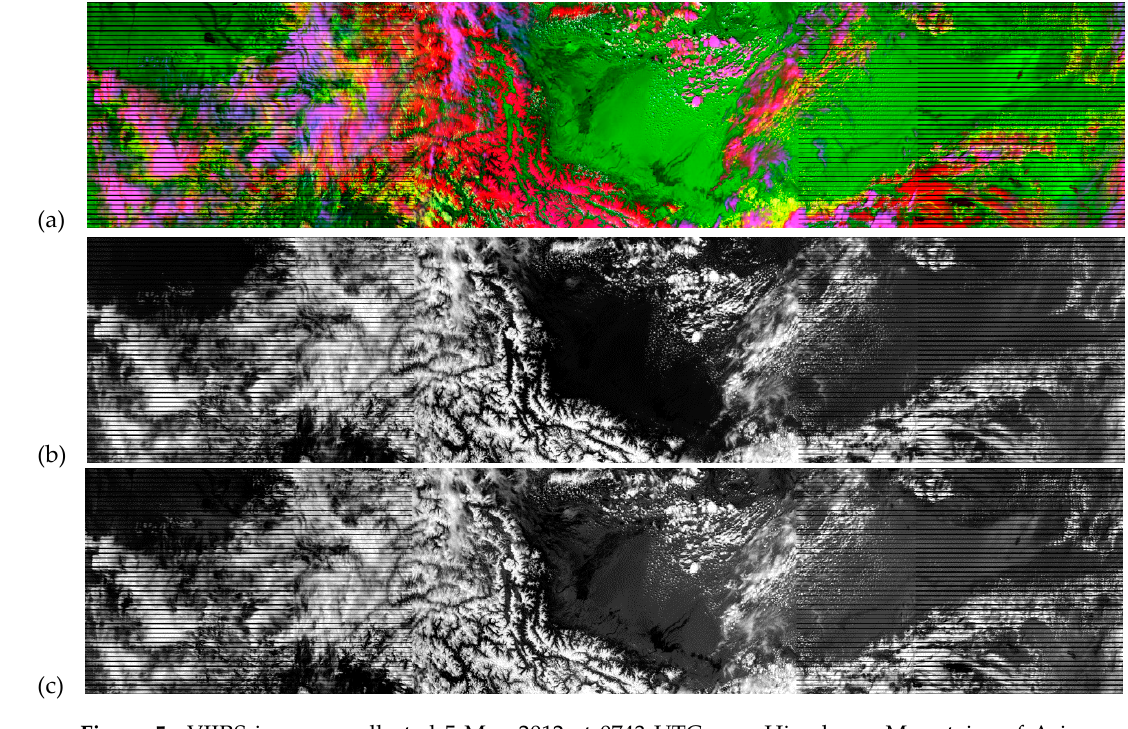
Figure 5. VIIRS imagery collected 5 May 2012 at 0743 UTC over Himalayan Mountains of Asia. ( a ) shows a color assignments are the same as used in Figure 1a. Cloud-free, sparsely vegetated regions appear green (e.g., in the image center) and reflect poorly in the M1 (412 nm) band shown in ( b ), when compared to the higher reflectances seen in other VIIRS bands, e.g., the M5 (672 nm) band shown by the lighter gray shades of the cloud-free land just to the right of the dendritic patter in ( c ). The lower reflectances in the M1 band make it ideal for identifying clouds over bare or sandy